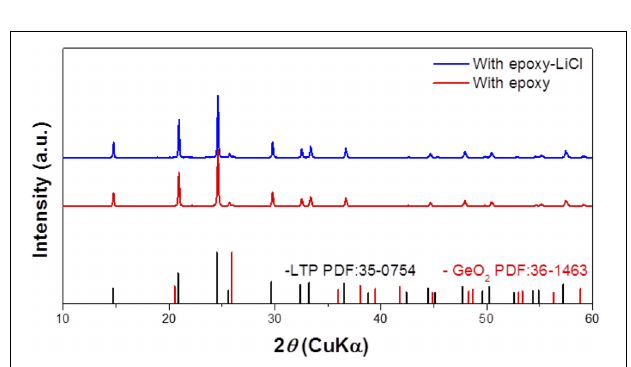
FIGURE 2 | X-ray diffraction (XRD) patterns of LAGTP, LAGTP-E, and